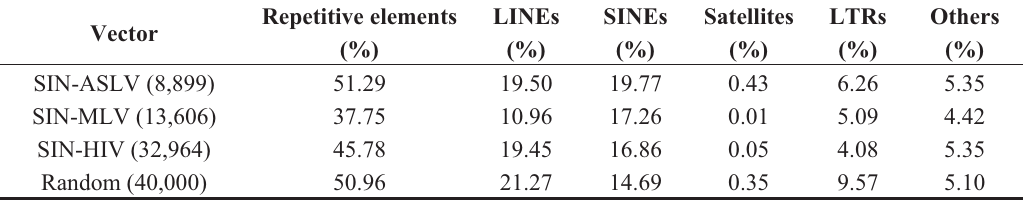
Table 2. Integrations targeting repetitive elements in the